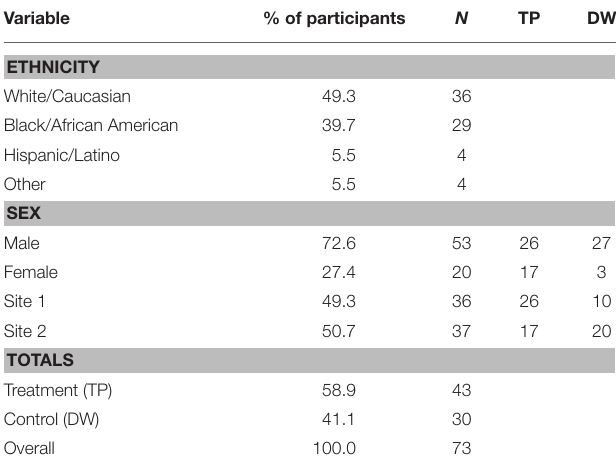
TABLE 1 | Characteristics of